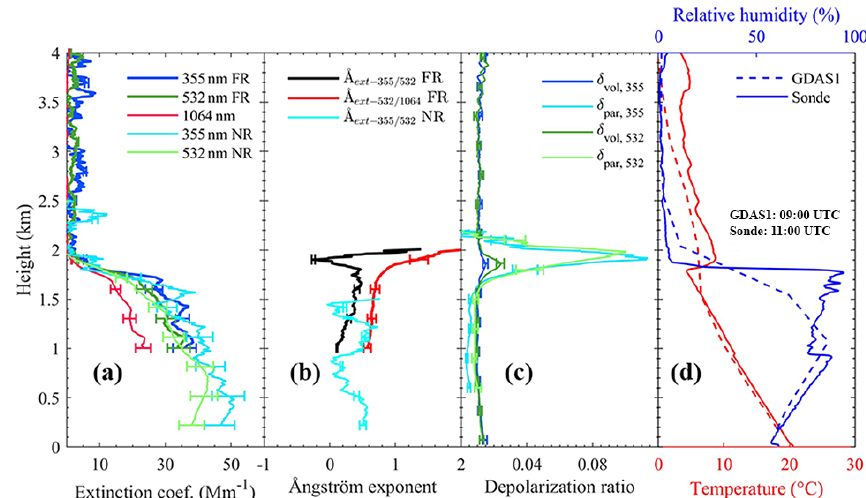
Figure 12. Height profiles of (a) particle extinction coefficients at 355nm (blue, FR from far-range signal, NR from near-range signal), 532nm (green) and 1064nm (red), (b) Ångström exponents computed from different wavelength pairs in panel (a) , (c) volume ( δ vol ) and particle ( δ par ) depolarization ratios and (d) relative humidity (blue) and temperature (red). The lidar observations were taken on 23 Novem- ber 2018 at 08:30–09:14UTC. The radiosonde was launched at 11:00UTC. GDAS1 data for 09:00UTC are shown for comparison.